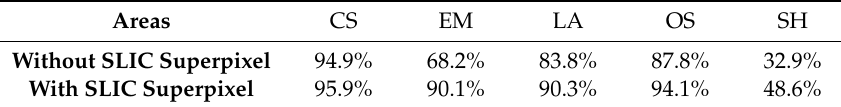
Table 7. Average MIoU of each classification.